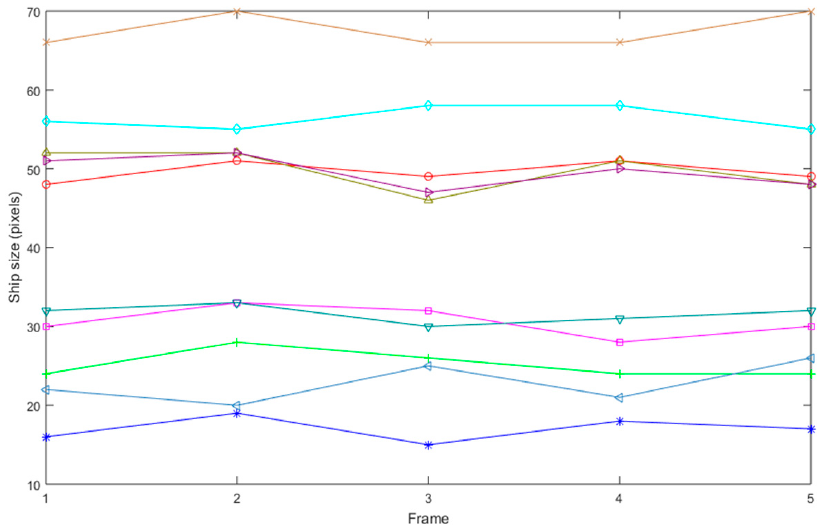
Figure 11. The size variations of 10 ships over multiple frames. Lines with different colors and marks denote different ships.